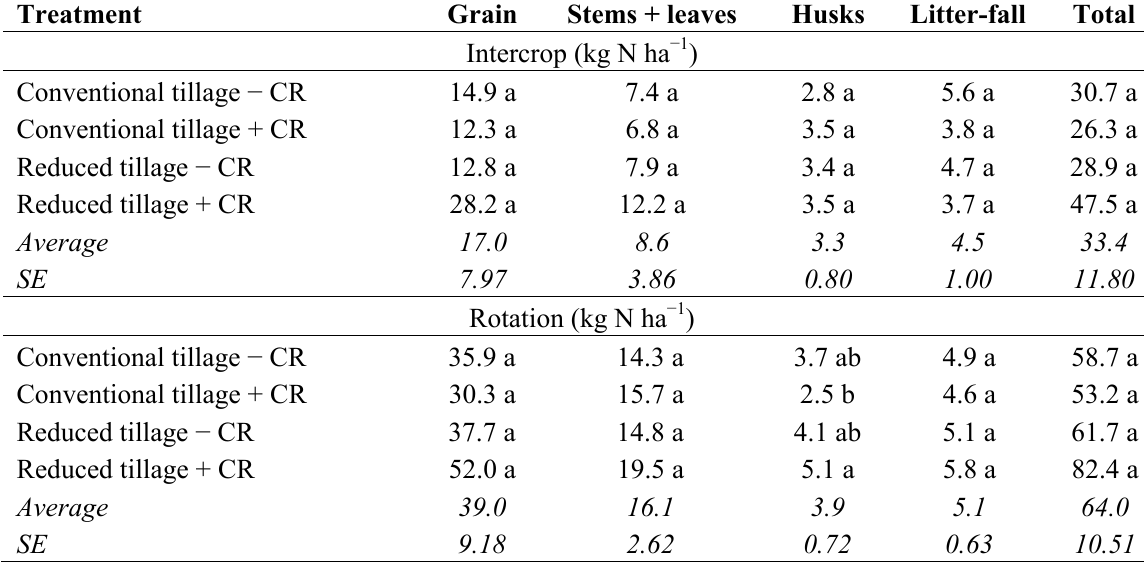
Table 5. Nitrogen fixed (kg N ha − 1 ) in soybean under intercrop and rotation with maize in Nyabeda, western Kenya, March–August 2007 cropping season.